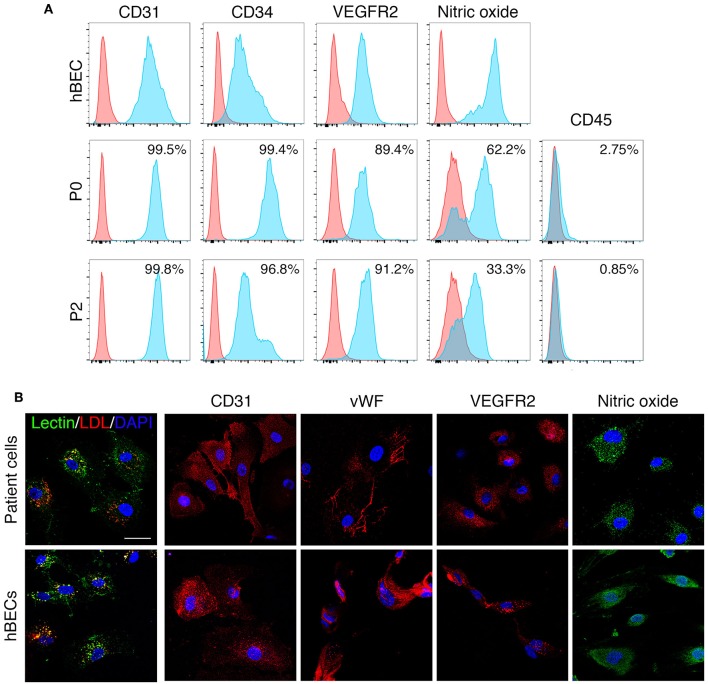
ECFC characteristics. ECFCs were isolated and cultured from peripheral blood collected from dialysis-dependent ESRD patients and were confirmed as mature endothelial cells via flow cytometry (A) and expression of specific proteins as determined by immunohistochemistry (B).